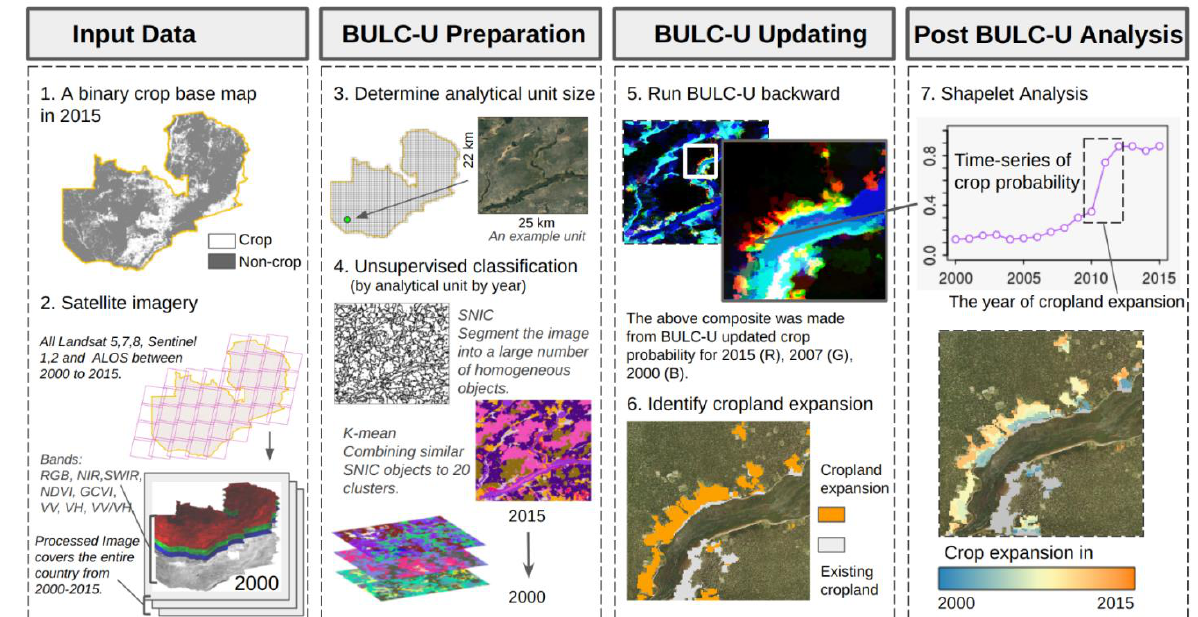
Figure 1. Study area figure showing Zambia study region, cropland coverage, and Landsat tile foot- print. The 812 validation samples are shown in the lower right inset map, with cropland labels for 2015 shown in blue and non-cropland labels in red.